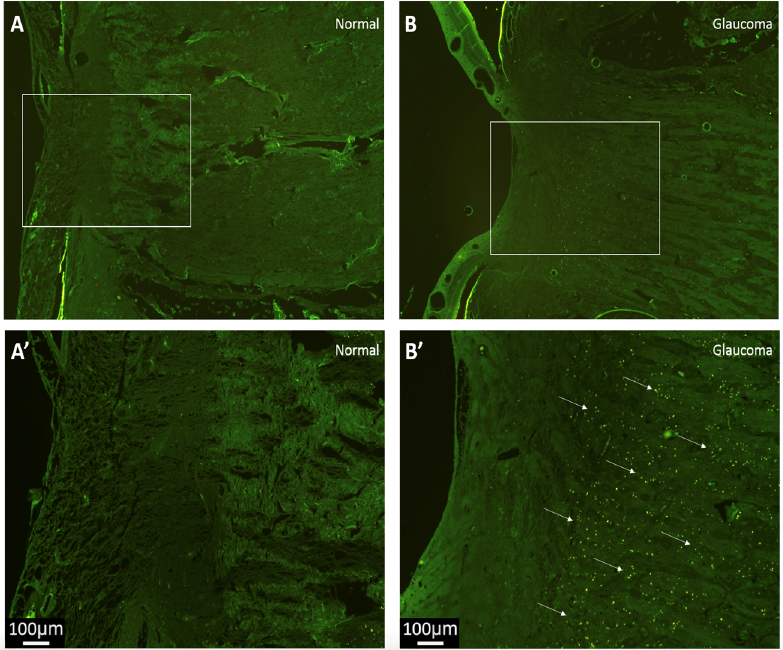
Figure 1. RPE-65 immunofluorescence of longitudinal sections through the laminar region of the human optic nerve from normal ( A , A’ ) and glaucoma ( B , B’ ) donors. Due to endogenous autofluorescence, the underlying tissue ultrastructure of the laminar region is visible (green) in both normal ( A ) and glaucoma ( B ) tissue sections, with the white box denoting the magnified LC region photographed in ( A’ , B’ ). A strong positive fluorescent RPE65 signal (bright green dots, indicated with arrows) was seen only in the laminar and post-laminar tissues of the glaucoma donor nerve ( B’ ) compared to the same region in the normal donor ( A’ ). Scale bar 100 µ